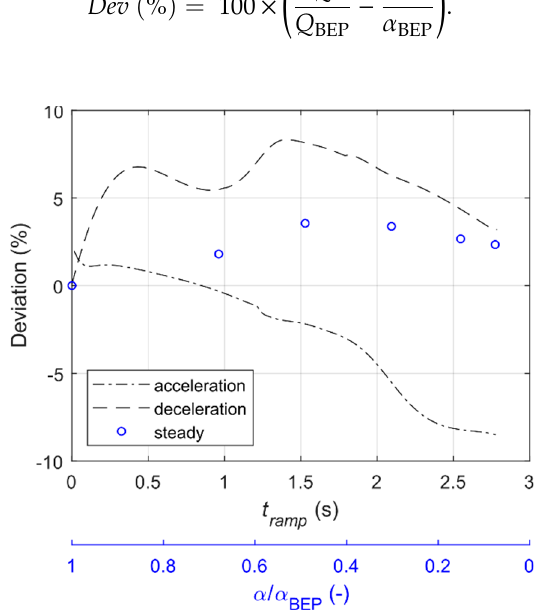
Figure 9. Deviation between the flow rates (transient and steady) and the GV opening, calculated from Equation (5).